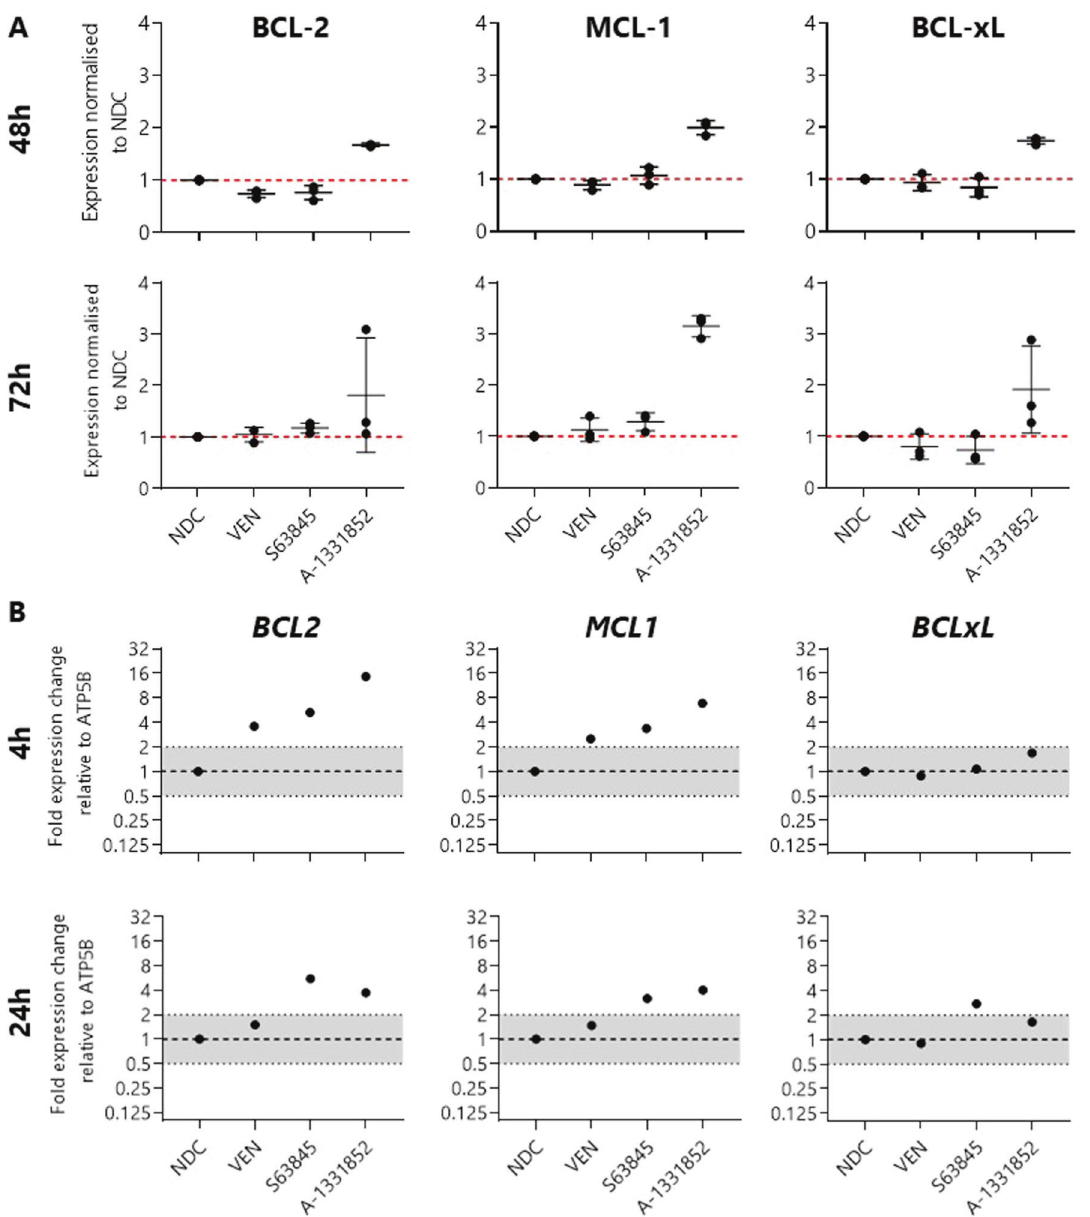
Fig. 2 BCL-xL inhibition induces upregulation of BCL-2, MCL-1, and BCL-xL in K562 cells. A Protein levels in K562 cells were quanti fi ed using median fl uorescence intensity and normalized to the no drug control (NDC) after treatment with 1 µM indicated BH3 mimetic after 48 h or 72 h, N = 3. ( B ) Gene expression of BCL2 , MCL1 , and BCLxL in K562 cells treated with 1 µM indicated BH3 mimetics for 4 h or 24 h, N = 1. Data are represented as mean ± SD. (healthy: 47.14 ± 7.61%; BP-CML: 18.63 ± 7.51%) signi fi cantly reduced the cell counts of BP-CML samples to a greater extent than those of the healthy controls (p = 0.0086, p = 0.0121 respectively), indicating a potential therapeutic window. PS presentation, cell membrane permeabilization, and the presence of active caspase-3 were measured in both the more mature CD34 - and primitive CD34 + populations to con fi rm that the decreases in cell counts were due to an increase in apoptosis initiation (Fig. 4B, C). In the healthy and BP-CML samples, the apoptotic responses to the BH3 mimetics within the CD34 - fraction were comparable. Within the CD34 + population, however, the BP- CML cells were signi fi cantly more sensitive than the healthy CD34 + cells to BCL-xL inhibition in combination with either BCL-2 (healthy: